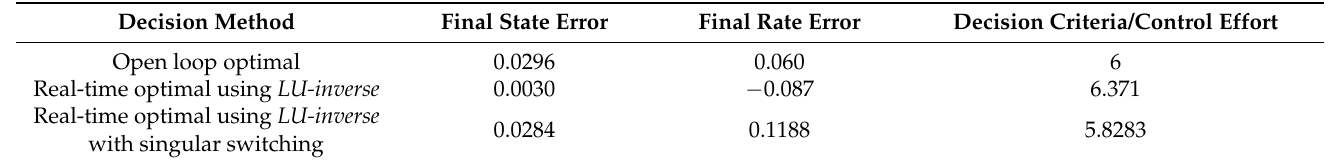
Figure 11. Comparison of real-time optimal methods with scaled time on the abscissae and respective ordinates titled in the subplot captions: solid line is open loop optimal (benchmark), dashed line is real-time optimal using backslash, thick dotted line is real-time optimal using LU-inverse with singular switching. ( a ) States, ( b ) rates, and ( c ) decision criteria or control. The ranges of the zoomed view in the inset are indicated by the respective scales. Table 7. Comparison of real-time optimal decision methods using LU-inverse matrix inversion.